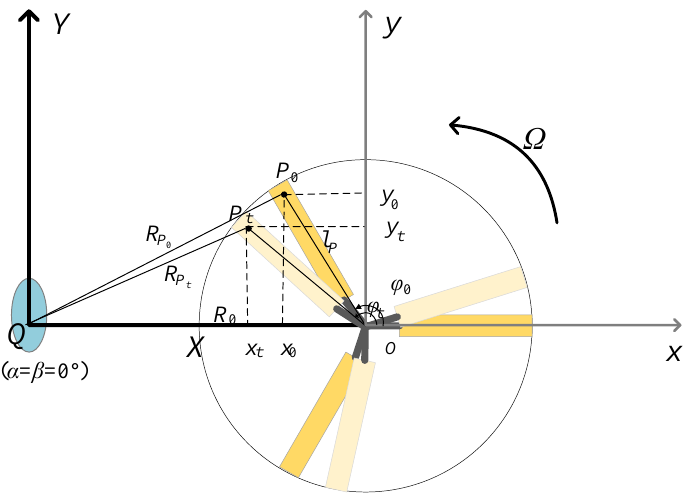
Figure 2. Blade rotation plane sketch. Figure 2. Blade rotation plane sketch. At time t , the point P rotates to the position of ( ,, 0 ) At time t , the point P rotates to the position of ( x t , y t , z = 0 ) , and the rotation angle is t   = + . The distance from point P to the radar is: ϕ t = Ω t + ϕ 0 . The distance from point P to the radar